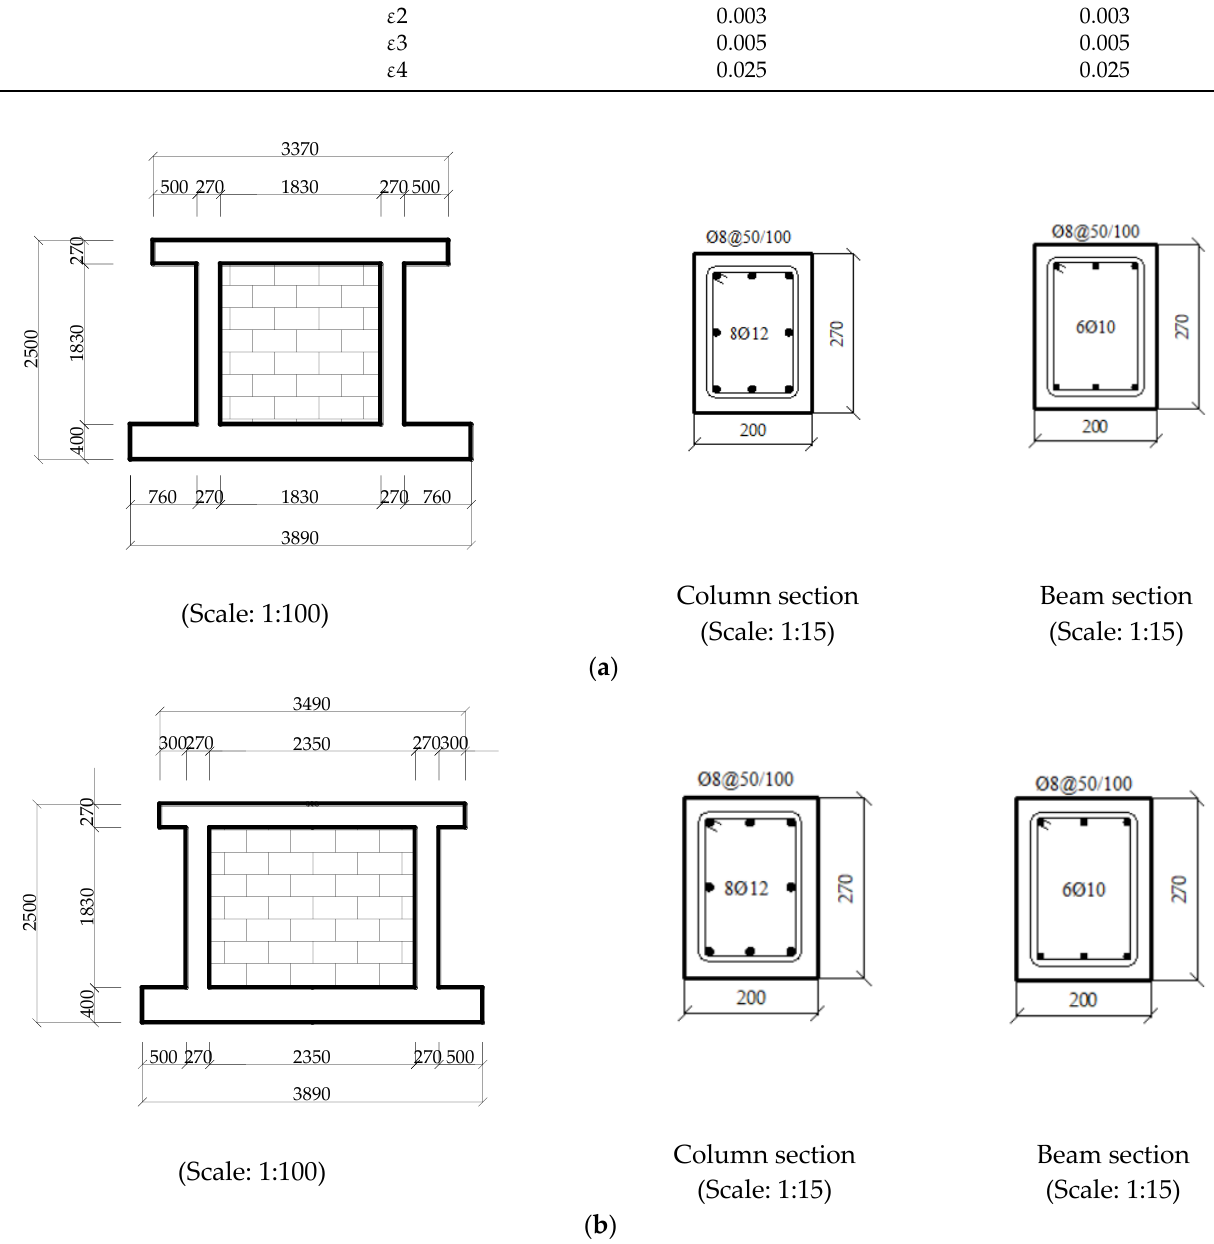
Figure 6. Frame size and reinforcement information: ( a ) De Risi et al. (2019) [30] ; ( b ) Ricci et al. (2018) [31]. Finite element modelings of the three test specimens were built in OpenSees. The lateral load is applied to the end of beam and the loading procedure described in the test Table 5. Mechanical properties of the material of test specimens. was adopted for the